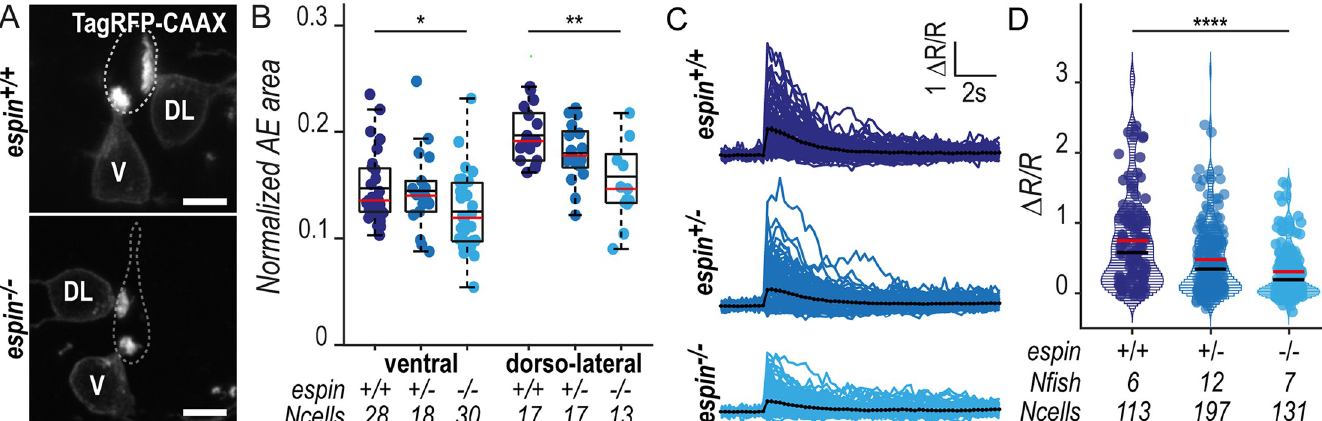
Fig 6. CSF-cNs with shorter apical extensions exhibit reduced mechanosensory response. (A) Z-projections from transversal sections of spinal cords with V and DL TagRFP-CAAX-positive CSF-cNs at 72 hpf illustrating the smaller AEs in espin −/− (bottom panel) compared with wild-type siblings (top panel). The central canal was outlined (dotted lines) according to ZO-1 staining. Scale bars, 5 μ m. (B) Quantification of the normalized area covered by the CSF-cN AE at 72 hpf in V and DL cells in espin −/− (light blue, N = 2 fish), espin +/− (blue, N = 2 fish), and espin +/+ (dark blue, N = 3 fish) siblings (1 representative experiment out of 2). In both CSF-cN subtypes, the AE size gradually decreases when cells miss 1 ( espin +/− ) or 2 ( espin −/− ) copies of the wild-type allele ( p V = 0.0112, df = 74, and t = 2.3311 in ventral cells; p DL = 0.0017, df = 45, and t = 3.0935 in DL cells). (C) Overlay of calcium transients in ipsilateral DL CSF-cNs in response to passive tail bending induced by a glass probe in paralyzed control wild-type larvae versus espin +/− and espin −/− siblings at 5 days (120 hpf). The average across cells is shown in black (pulled data from 4 experiments). (D) The amplitude of CSF-cN calcium transients shown in (C) is represented as the ratio of peak fluorescence over baseline ( Δ R/R) and is gradually reduced in espin +/− and espin −/− compared with wild-type siblings in a wild-type allele number-dependent manner ( p = 1.1102 × 10 − 6 , df = 1309, and t = 8.462). Underlying data can be found in S1 Data. AE, apical extension; CSF-cN, cerebrospinal fluid-contacting neuron; df, degrees of freedom; DL, dorsolateral; hpf, hours post fertilization; V, ventral; ZO-1,